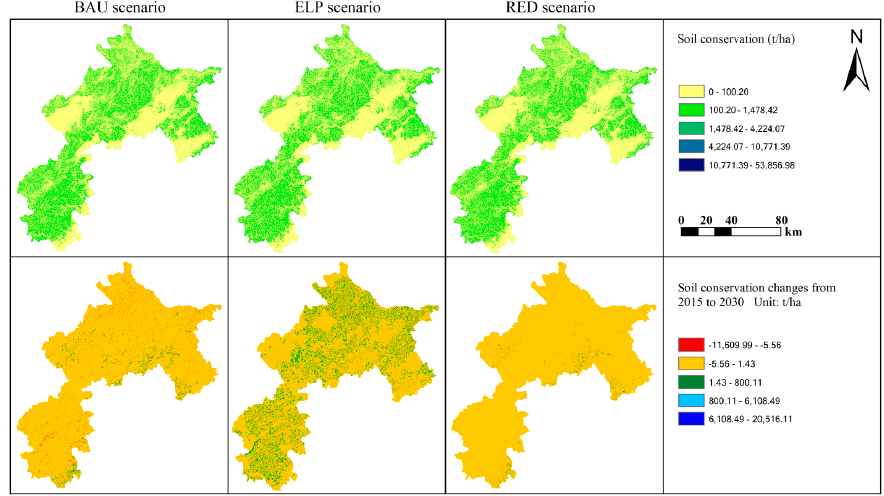
Figure 6. Top, spatial distributions of soil conservation (SC), and bottom, spatial distributions of changes in SC from baseline, in 2030, under the BAU, RED, and ELP scenarios.